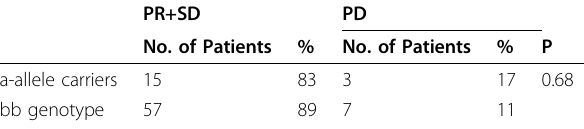
Table 5 Frequency and distribution of eNOS intron 4 VNTR alleles in 72 patients with partial response or stable disease and 10 patients with progressive disease PR+SD